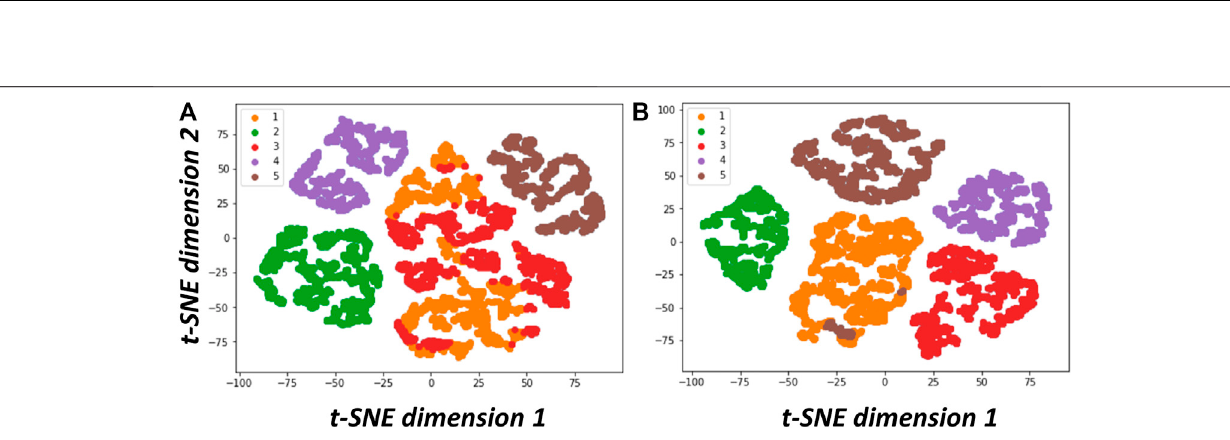
Frontiers in Bioinformatics |